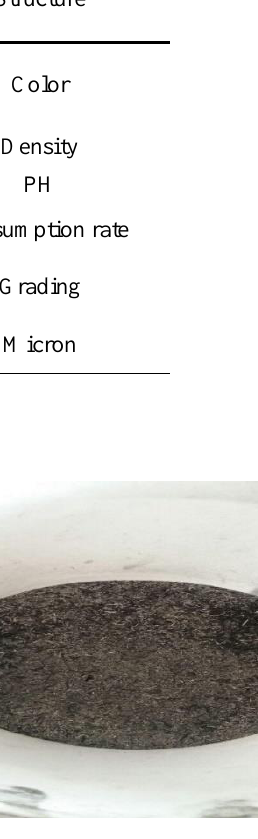
Figure 1. Consumption microsilica. Figure 2. Ashes of rice paddy husk